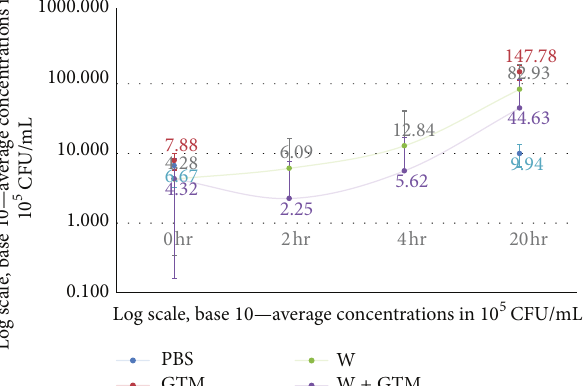
Figure 1: Colony formation of E. coli in PBS or pelvic washings ± GTM. PBS: phosphate-buffered saline. GTM: gelatin-thrombin matrix tissue sealant. W: pelvic